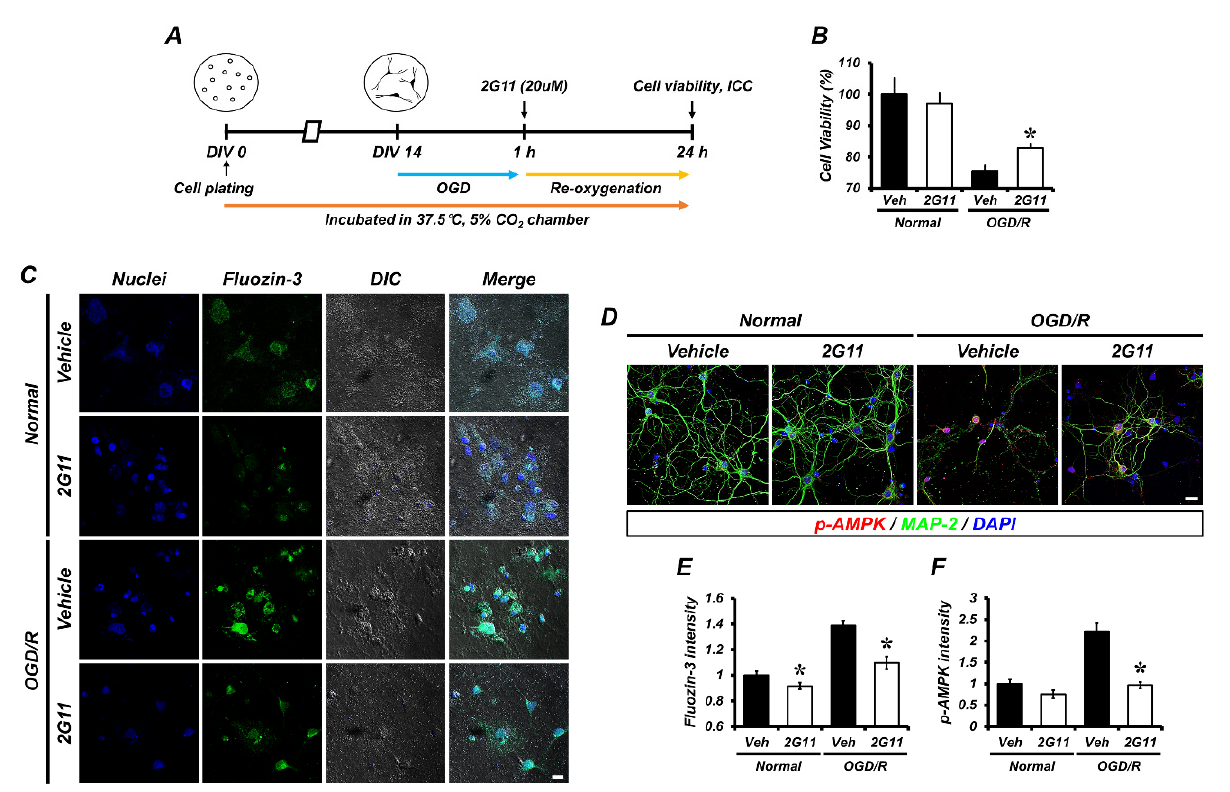
Figure 1. The 2G11 treatment protected cells against OGD/R injury in the primary hippocampal neuron culture. ( A ) Timeline showing the experimental design. ( B ) Cell viability was determined using the MTT assay. Data are the mean ± SEM. * p < 0.05 vs. vehicle-treated OGD/R group (Kruskal–Wallis test followed by a Bonferroni post-hoc test: chi square = 108.442, df = 3, p < 0.001). ( C ) Fluorescent and DIC merge micrographs of FluoZin-3 (green) expression in primary hippocampal neurons. Nuclei are stained with DAPI (blue). Scale bar = 10 μ m. ( D ) Representative images of MAP-2 (green) and p-AMPK (red) co-staining in primary hippocampal neurons. Scale bar = 20 μ m. ( E ) Bar graph showing the fluorescence intensity of FluoZin-3. Data are the mean ± SEM. * p < 0.05 vs. vehicle-treated OGD/R group (Kruskal–Wallis test followed by a Bonferroni post-hoc test: chi square = 79.532, df = 3, p < 0.001). ( F ) Bar graph showing the fluorescence intensity of p-AMPK. Data are the mean ± SEM. * p < 0.05 vs. vehicle-treated OGD/R group (Kruskal–Wallis test followed by a Bonferroni post-hoc test: chi square = 69.592, df = 3, p < 0.001).